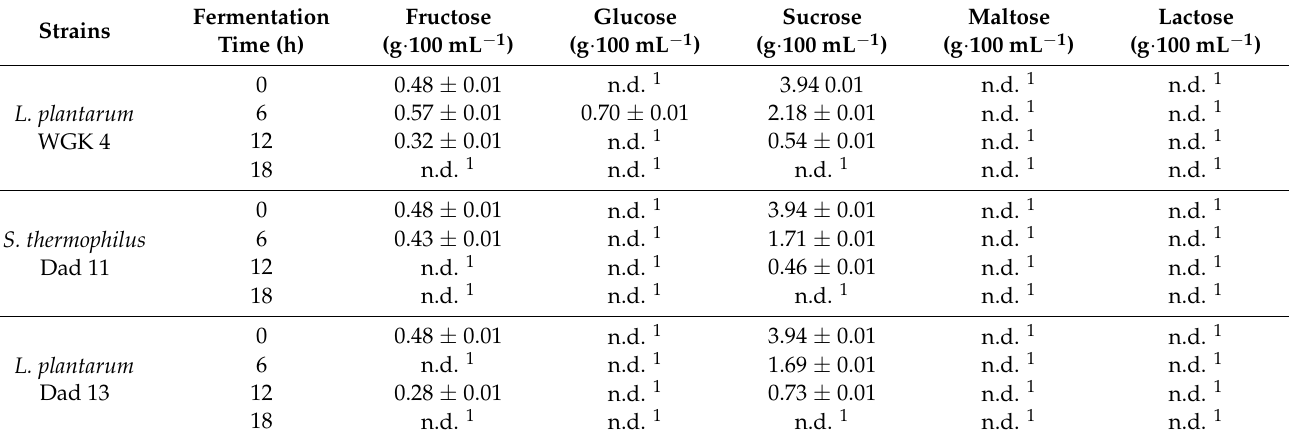
Table 5. Sugars profile of black soy milk during fermentation by Indonesian indigenous LAB (18 h, 37 ◦